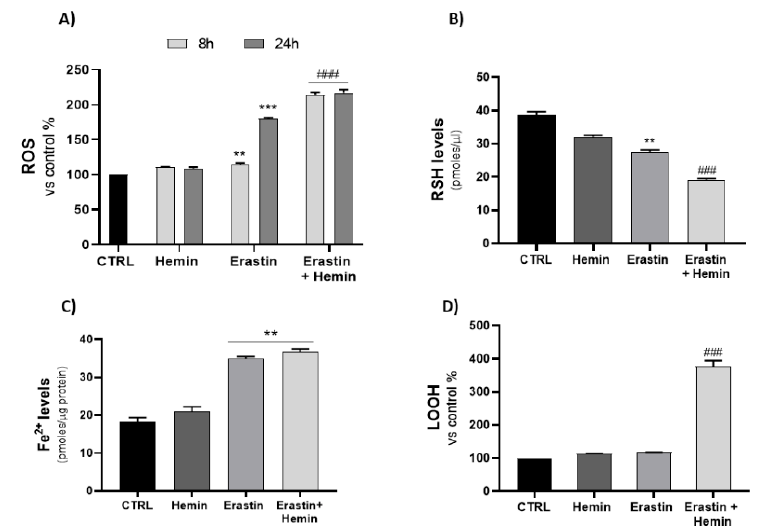
Figure 2. ( A ) Evaluation of the effects of hemin, erastin and an erastin/hemin combination treatments on ROS levels (** p < 0.005, *** p < 0.0005 vs. CTRL; ### p < 0.0005 vs. erastin). ( B ) Measurement of non-protein thiol group (RSH) concentrations after 24 h of treatment (** p < 0.005, *** p < 0.0005 vs. CTRL; ### p < 0.0005 vs. erastin). ( C , D ) Evaluation of Fe 2+ and LOOH levels after 24 h of treatment (** p < 0.005, *** p < 0.0005 vs. CTRL; ### p < 0.0005 vs. erastin). The results are expressed as means ± SEM.